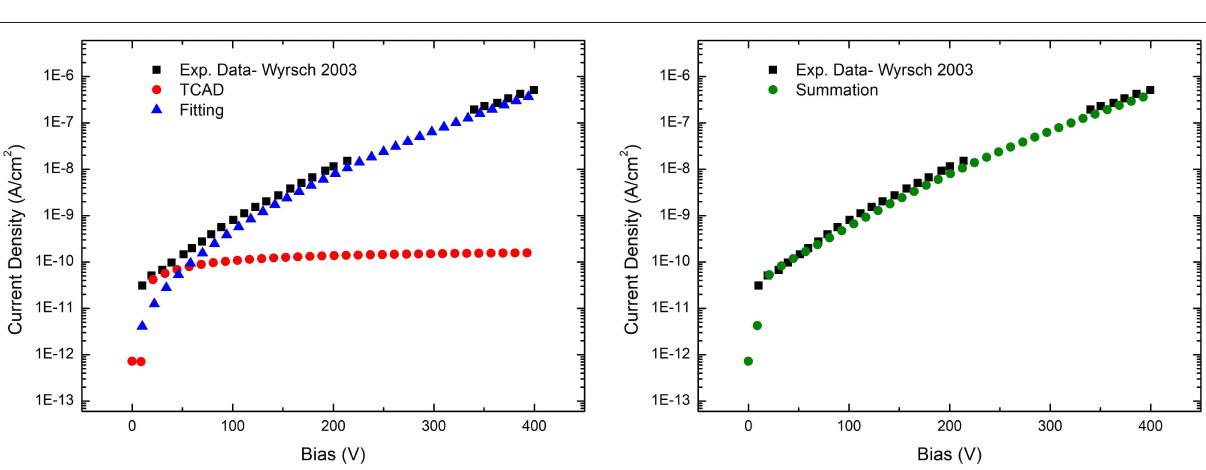
FIGURE 5 | Comparison of experimental (black square) and simulated (red circle) current density characteristics as a function of externally applied bias for the 30 µ m thick a-Si:H n-i-p device. A fitting function (Blue triangles) described by Equation (4) was employed to fit the field dependent components of the data. The summation of the simulated and fitted result (green circles) compared to the experimental is presented on the